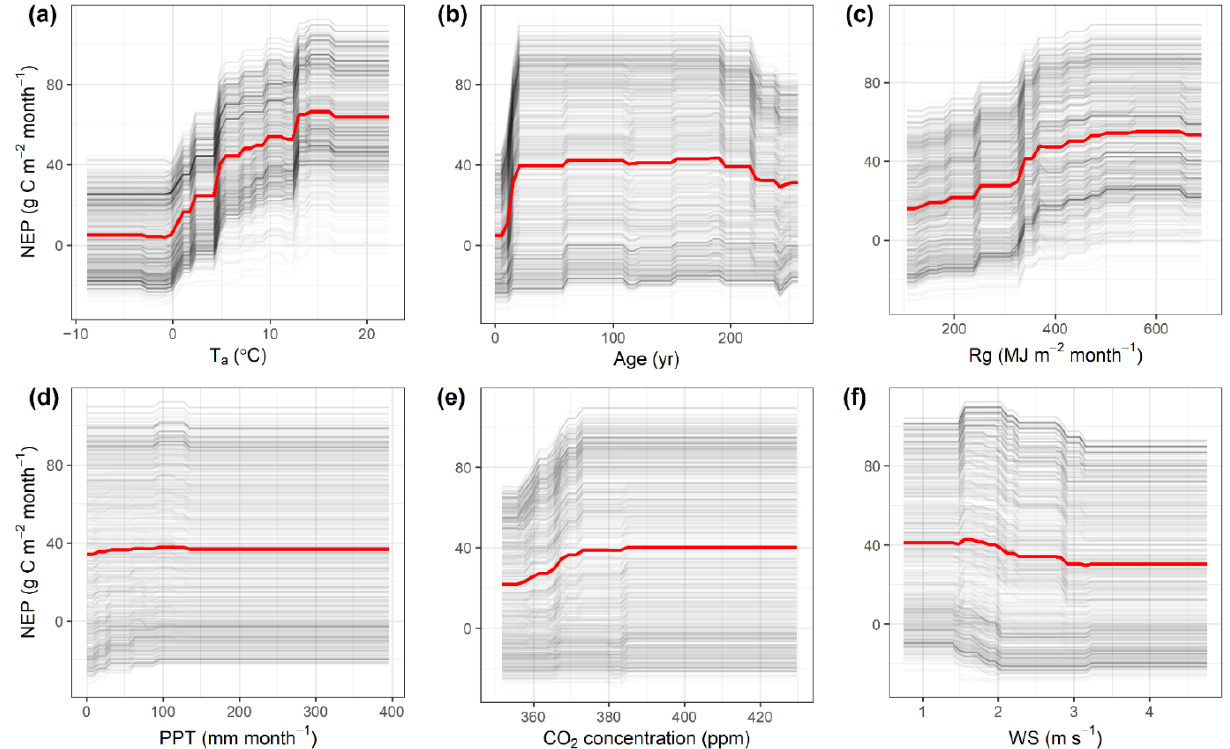
Figure 3. Partial dependence plots for NEP with respect to changes in: ( a ) air temperature (T a ); ( b ) age; ( c ) global radiation (Rg); ( d ) precipitation (PPT); ( e ), CO 2 concentration; ( f ) wind speed (WS). The red curves indicate the average partial relationships. Grey curves are individual conditional expectation (ICE) curves that represent the partial relationship across individual observations in the data.